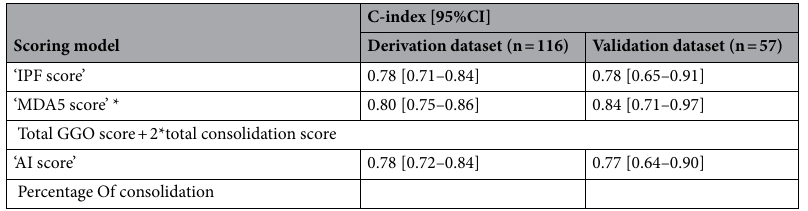
Table 3. Comparison of the prediction performance of each model. * ‘MDA5 score’ model performed significantly better than ‘IPF score’ model (p = 0.02). C-index, concordance index; 95%CI, 95% confidence interval; IPF, idiopathic pulmonary fibrosis; MDA5, anti-melanoma differentiation-associated gene 5; GGO, ground-glass opacity; AI, artificial intelligence.